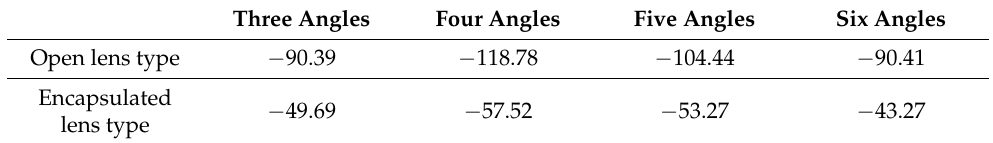
Table 1. AIC at each number of reference angle k in Equation (1) for open and encapsulated lens types. A smaller AIC value statistically means that a smaller approximation error is obtained using a smaller number of reference